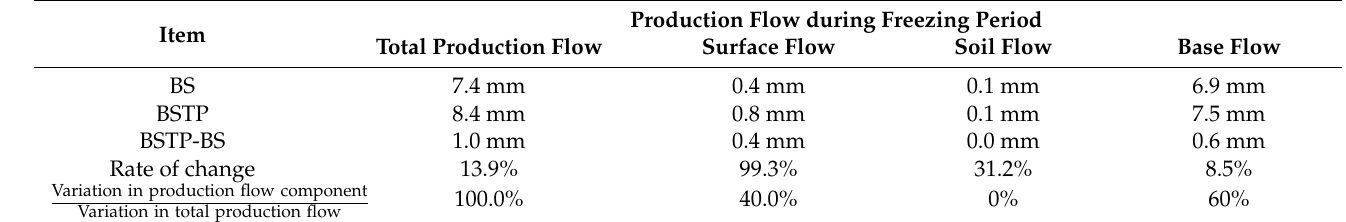
Table 9. Influences of temperature and precipitation on the runoff component variation during the freezing period.